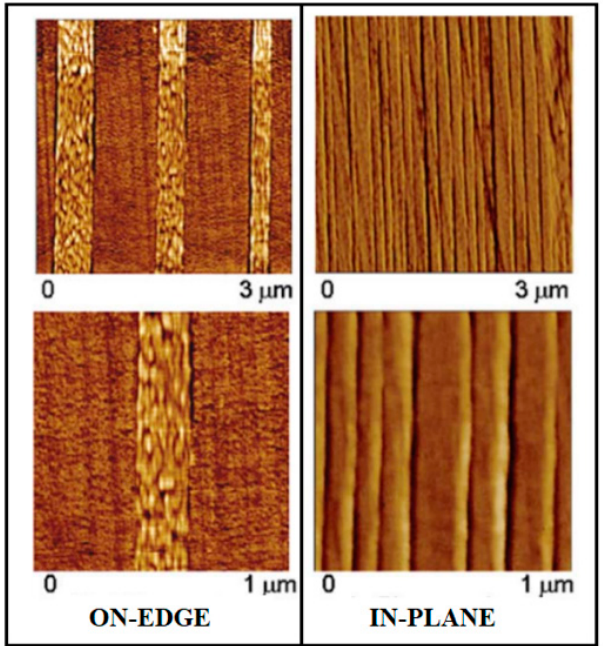
Figure 7. Example of typical AFM phase images of multilayered film cross-section with on- edge and in-plane orientations. Adapted from [133] with permission from John Wiley and Sons. Copyright ©